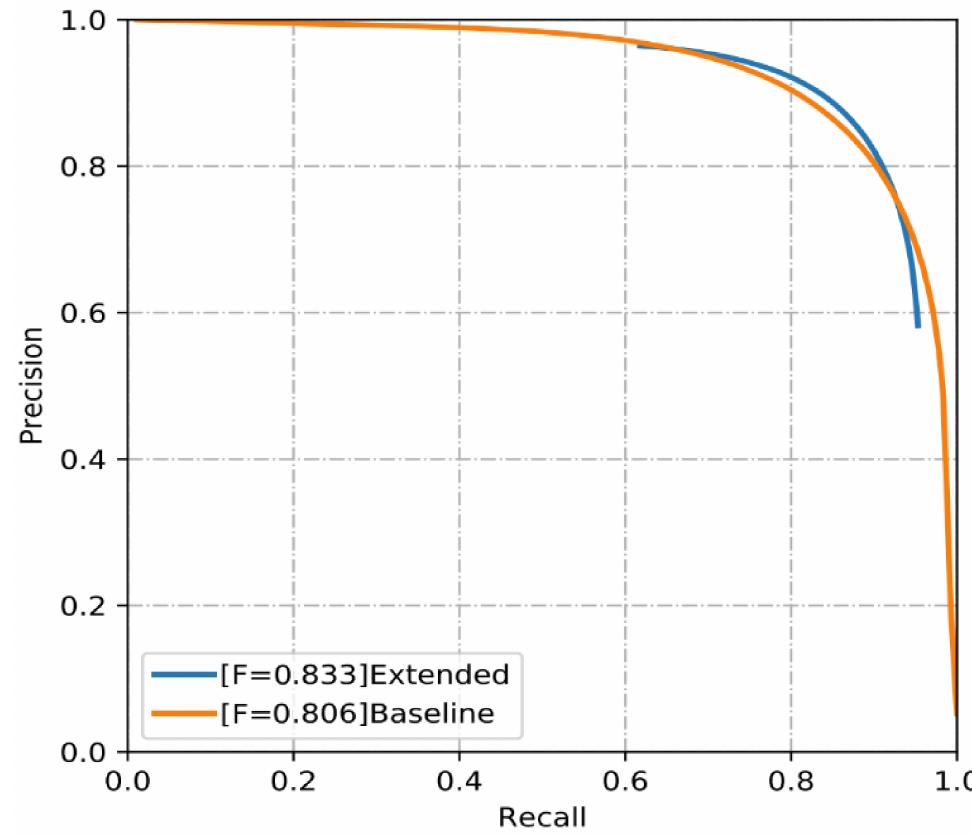
Figure 10. The precision-recall curves generated by the threshold